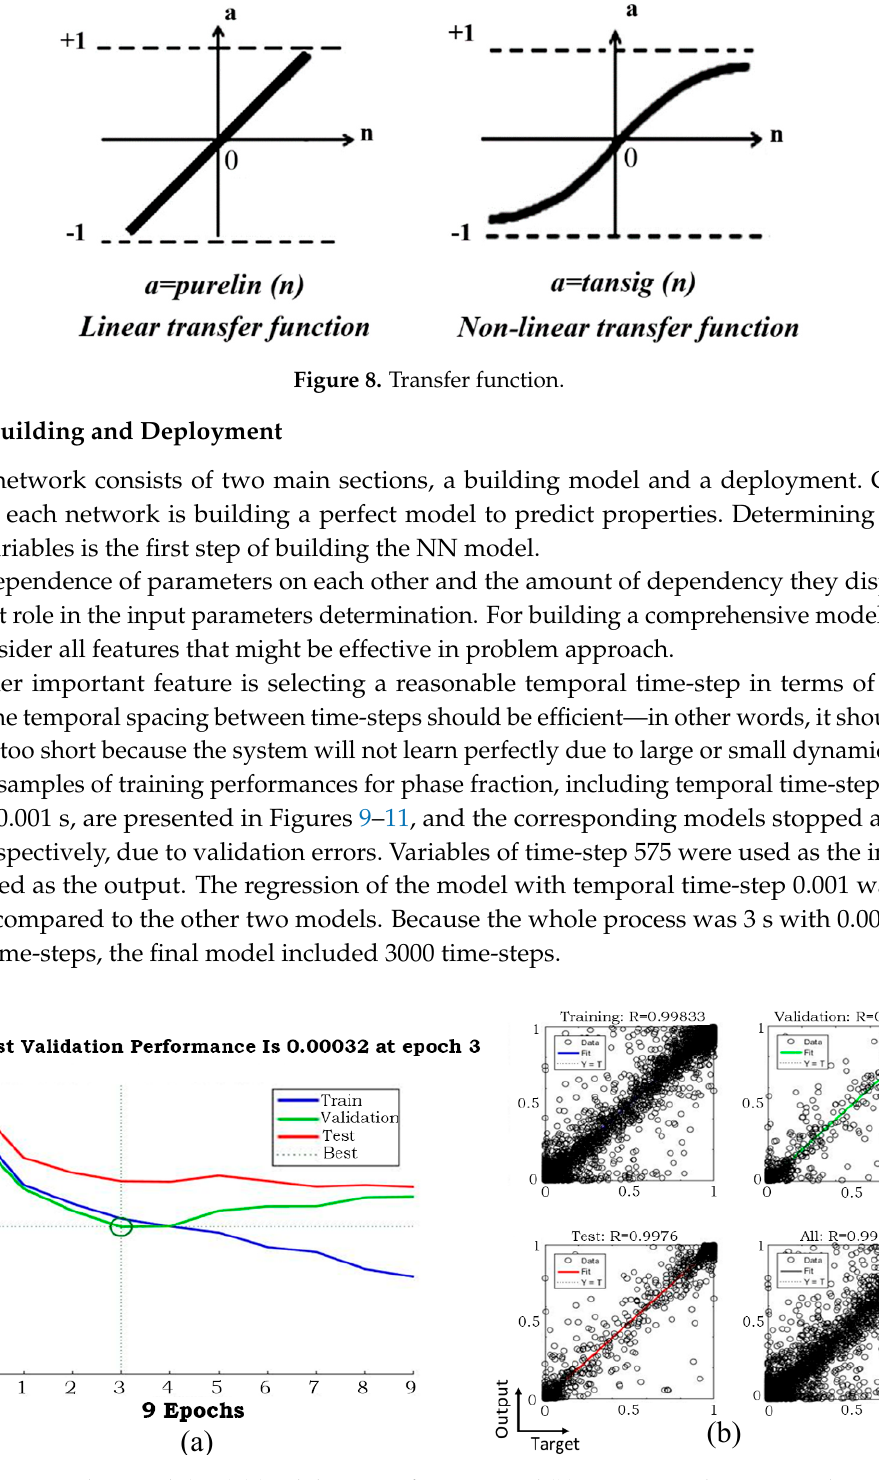
Figure 9. Neural network (NN) ( a ) validation performance and ( b ) regression when temporal time-step was 0.004 s.